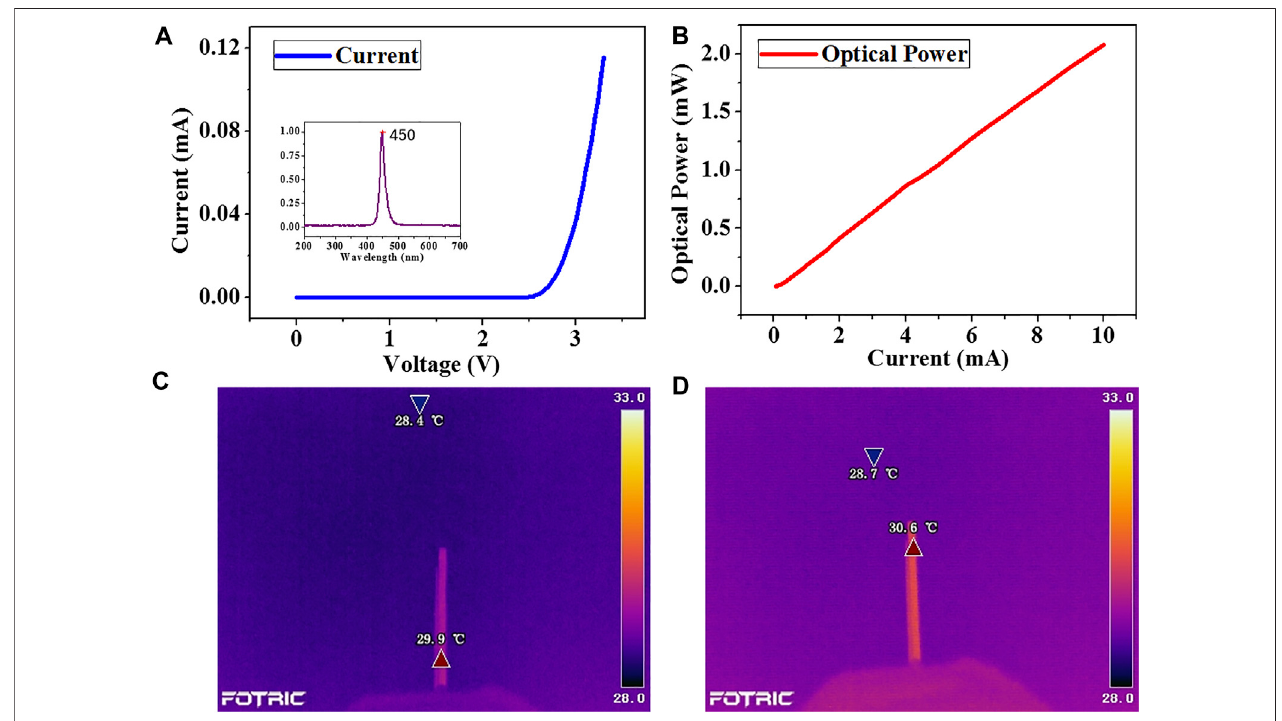
FIGURE 6 | Characterization of the optical and thermal properties of the optrode (A) Current – Voltage curves, illustration is the emission wavelength (B) Current – Power curves (C) Initial temperature (D) Temperature of the optrode after the power is on.